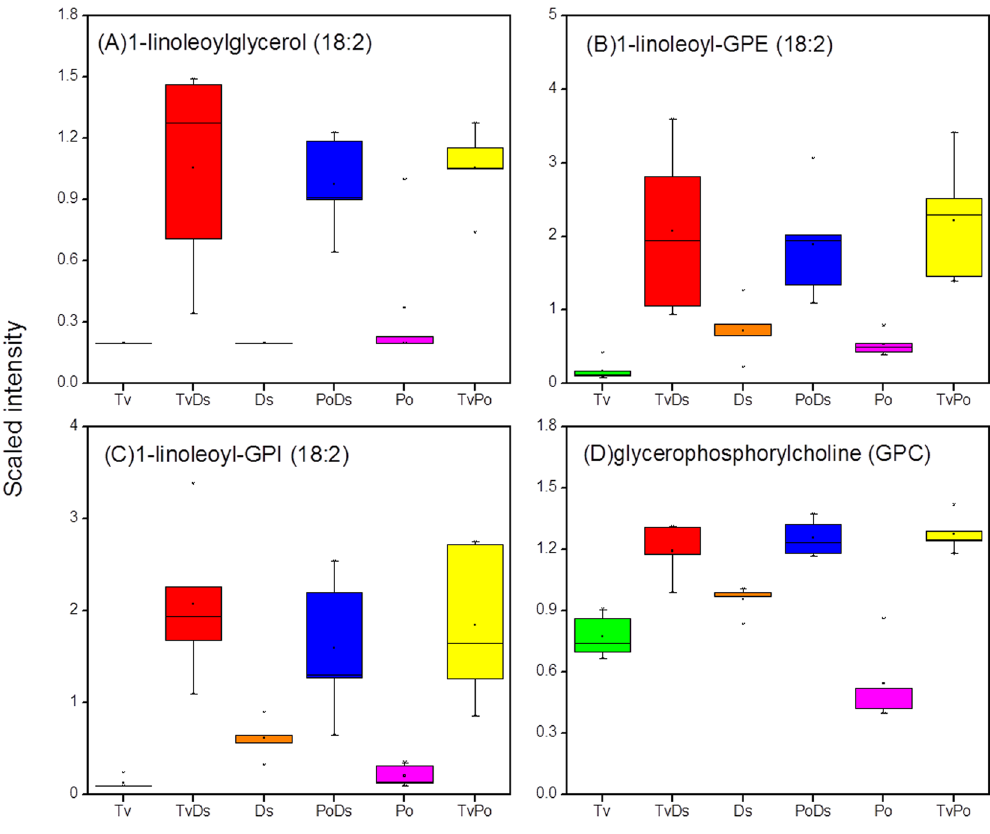
Figure 6. Lipolysis products significantly increase in all interaction zones. ( A ) 1-linoleoylglycerol; ( B ) 1-linoleoyl-GPE; ( C ) 1-linoleoyl-GPI; ( D ) glycerophosphocholine